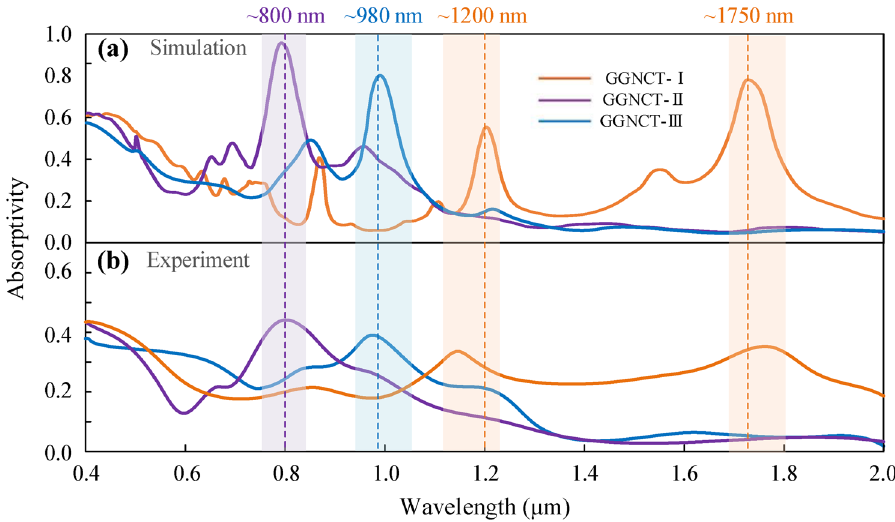
Figure 3. The simulated and measured absorption spectrums of the GGNCT-I and II and III in a wavelength range of 0.4–2 μm, which are colored by orange, purple, and blue, respectively. ( a ) The simulated absorption spectrums and ( b ) the measured absorption